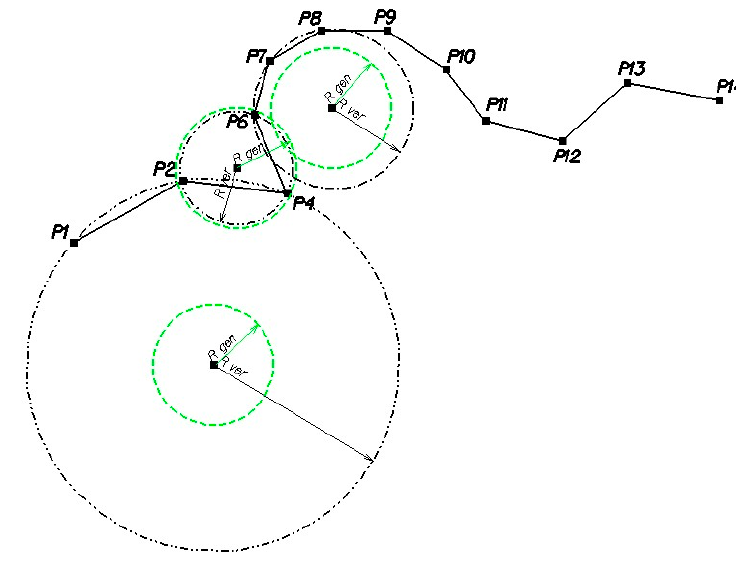
Figure 3. Advanced stage of generalization. ISPRS Int. J. Geo-Inf. 2018 , 7 , x FOR PEER REVIEW